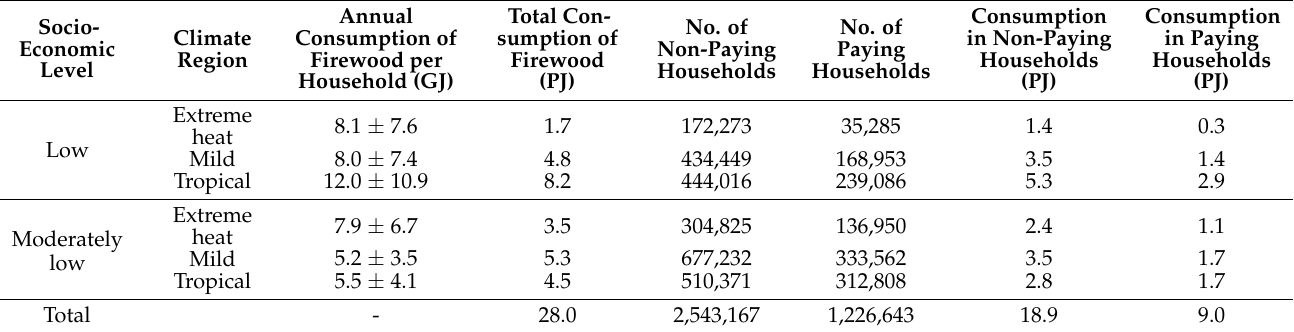
Table 5. Consumption of firewood per household, number of households, and total consumption of firewood in paying and non-paying MSU